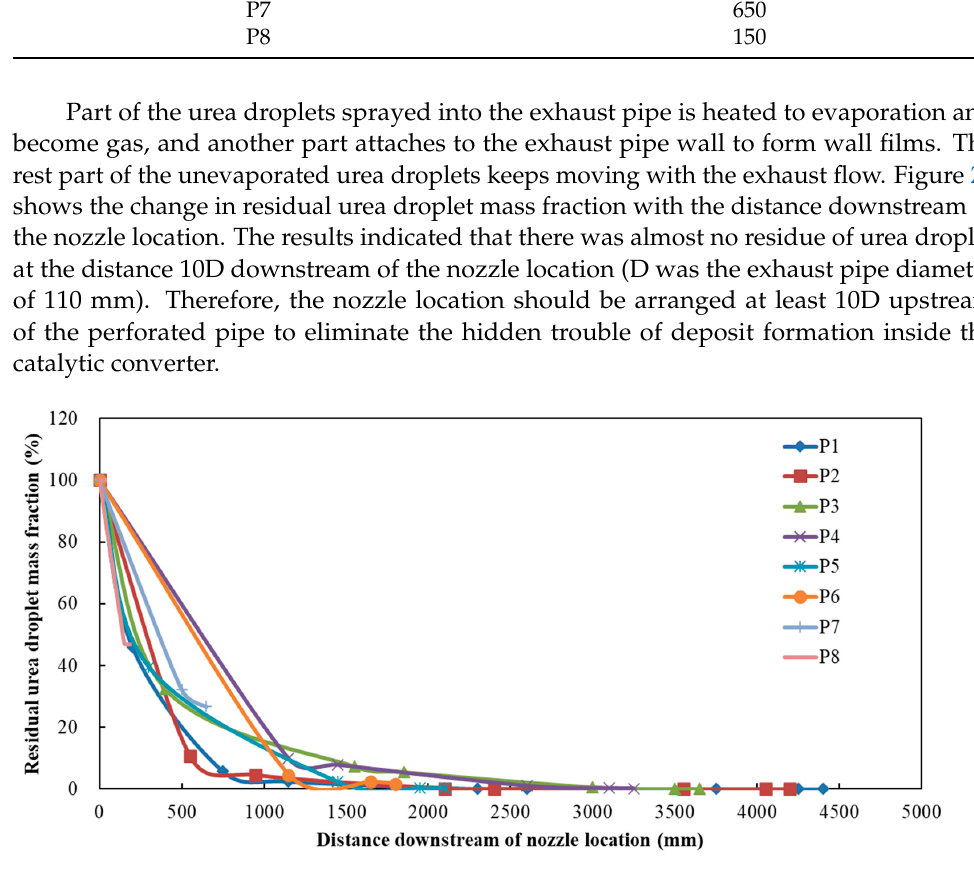
Figure 23. Residual urea droplet mass fraction at di ff erent positions.